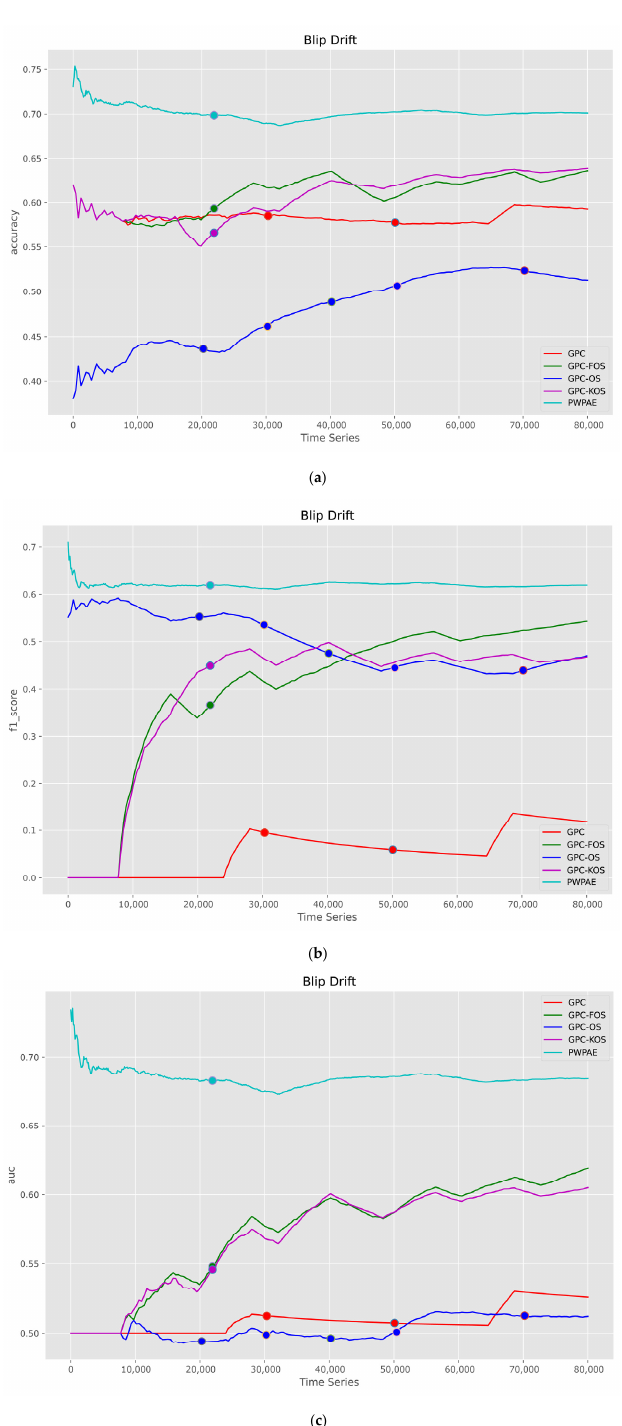
Figure 12. Visualisation of classi fi cation metrics as time series for a blip type of drift—( a ) accuracy, ( b ) F1-score, ( c ) AUC.